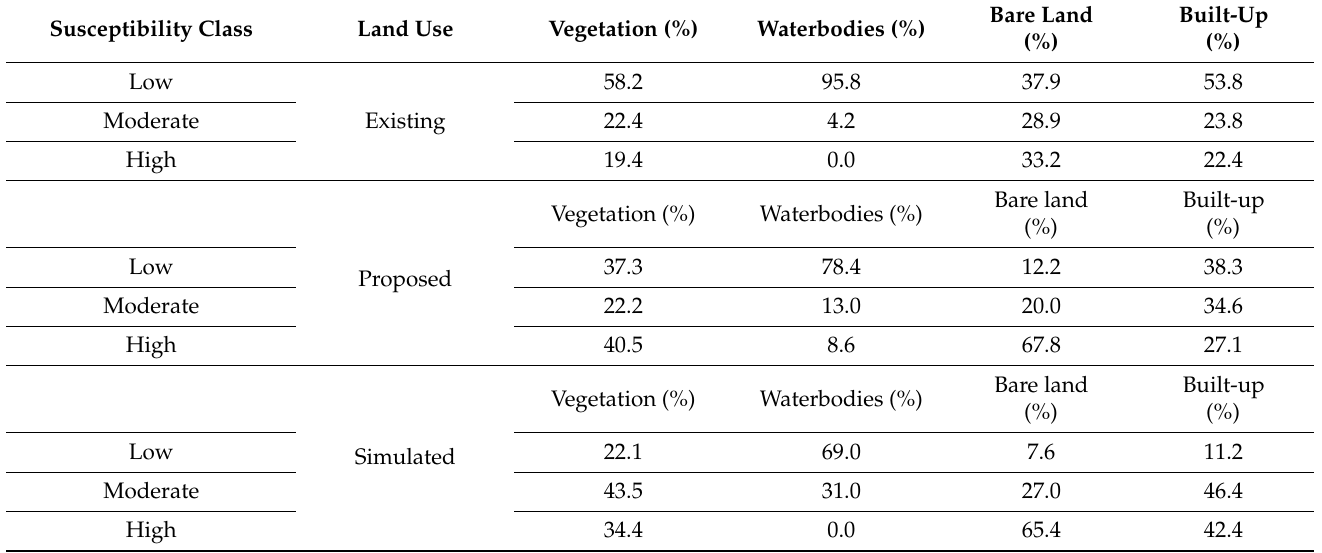
Table 5. Percentage of landslide susceptibility classes in every LULC class in different scenarios.